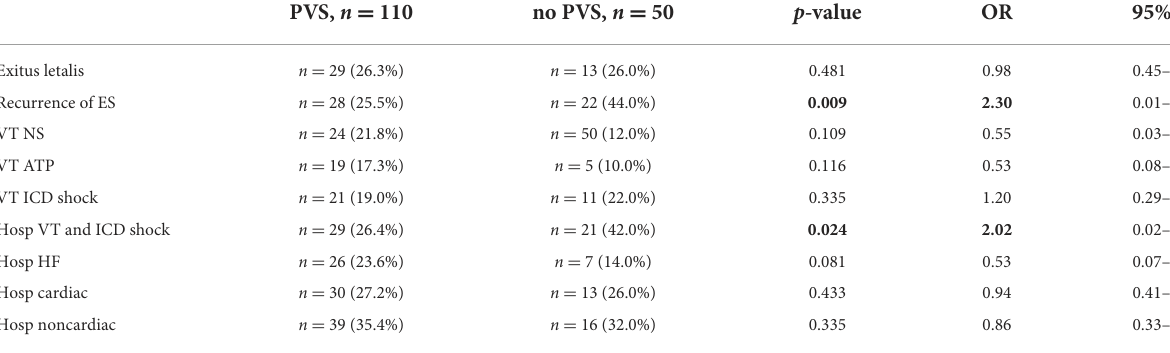
TABLE 10 Analysis between postprocedural PVS vs. waiver or impossible PVS.